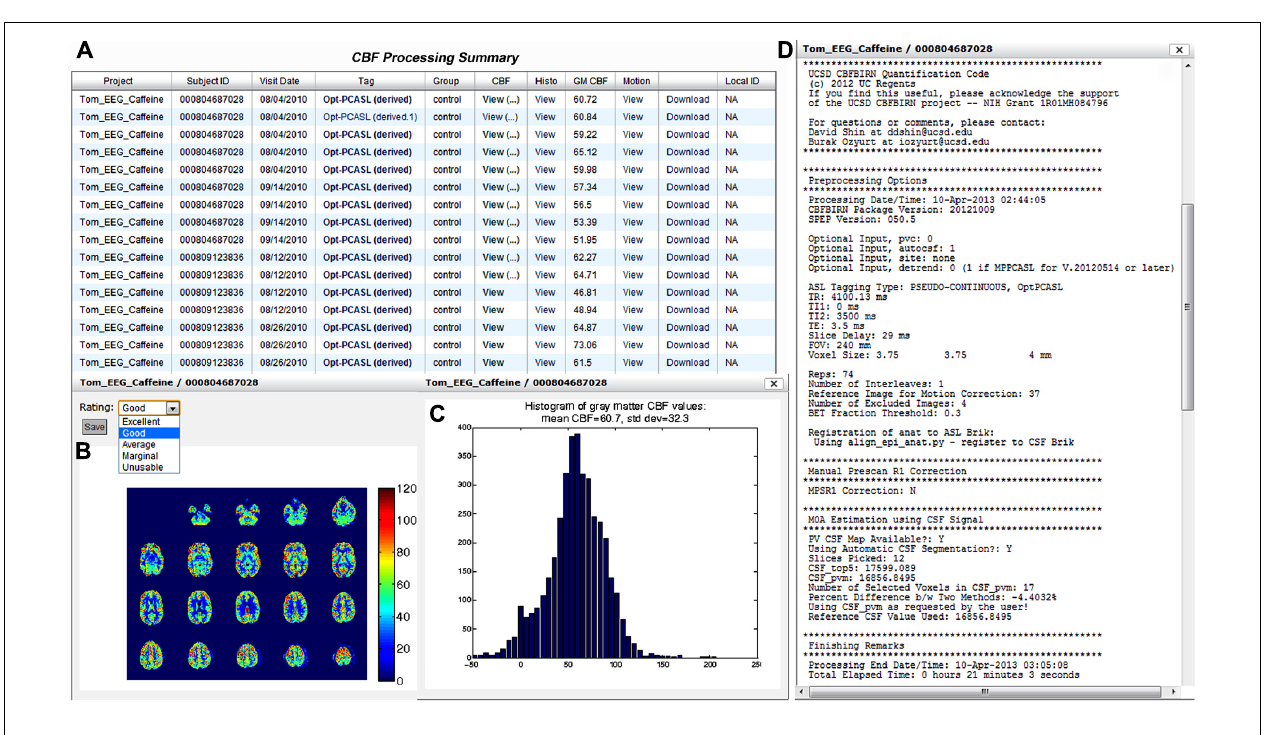
FIGURE 9 | Cerebral blood flow Processing Summary Page that presents a table (A) containing the complete list of successfully processed jobs down the rows. For each job, the table provides useful details such as the subject ID, scan date, experimental condition, ASL